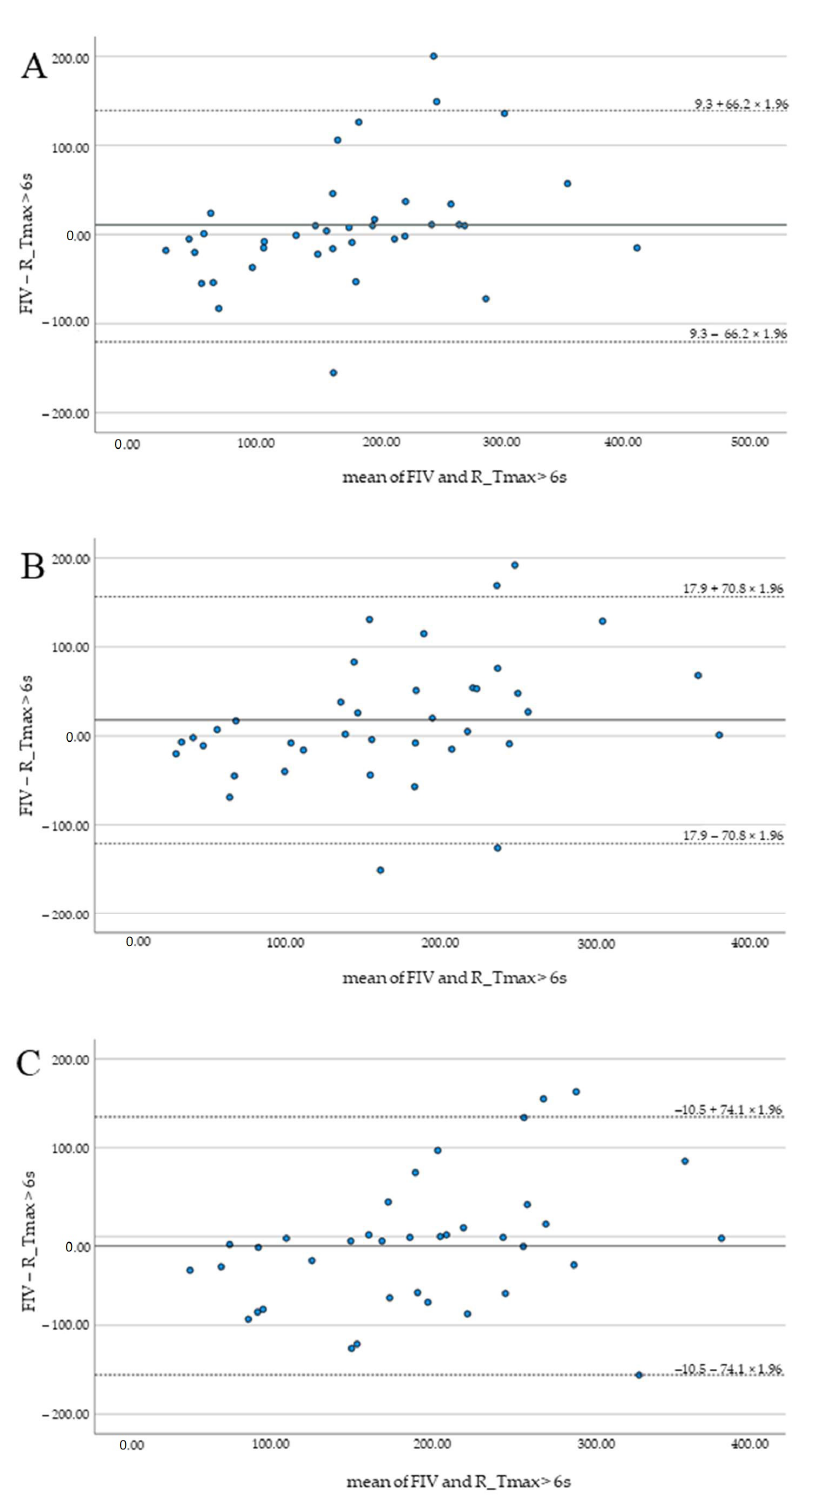
Figure 2. Bland–Altman plots illustrating the agreement of FIV and HV for RAPID ( A ), Brainomix ( B ), and Syngo ( C ).